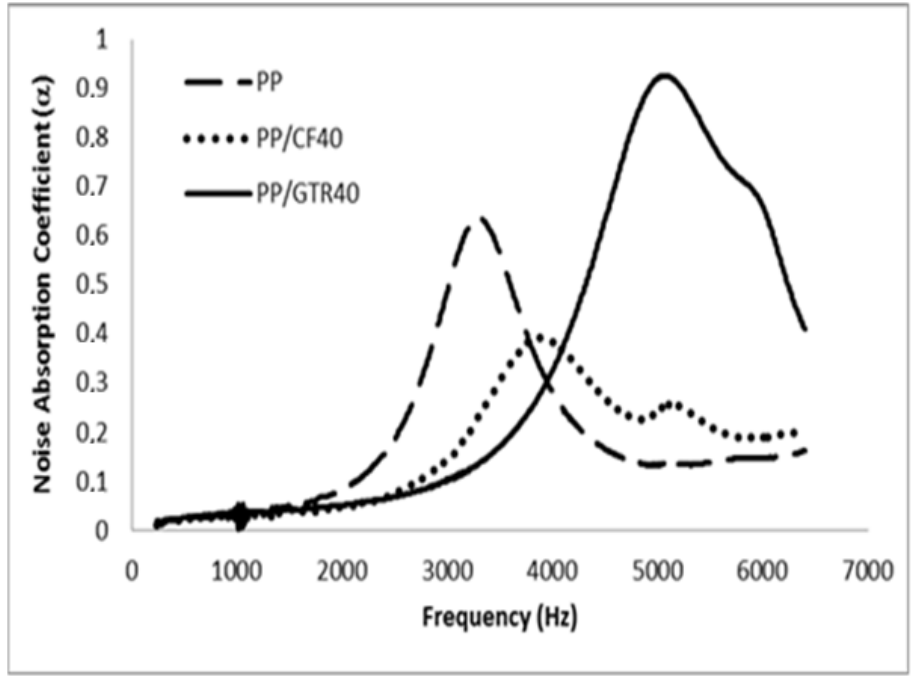
Figure 13. α values for PP and GTR/PP and CFs/PP composites at 40 % composition.